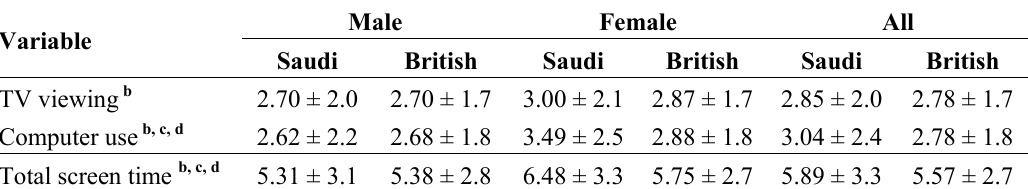
Table 4. Sedentary behaviors among Saudi and British adolescents.